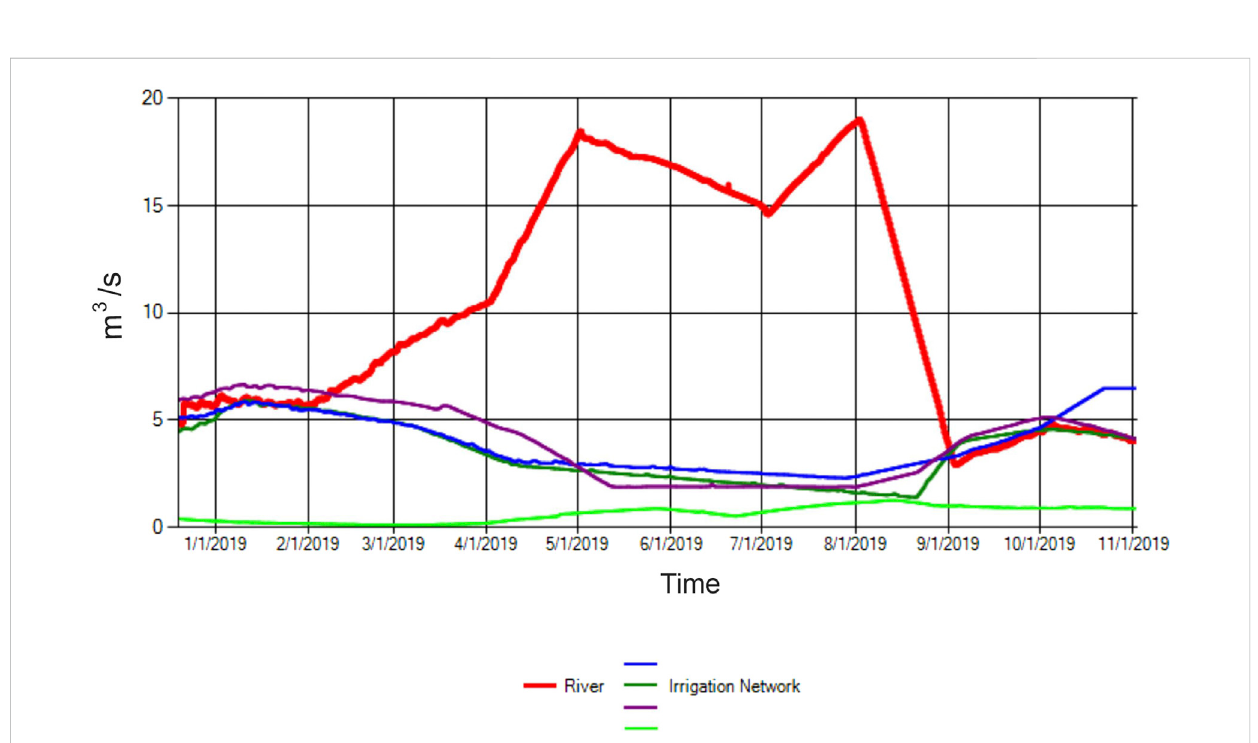
FIGURE 15 Flow (m 3 /s) as a function of